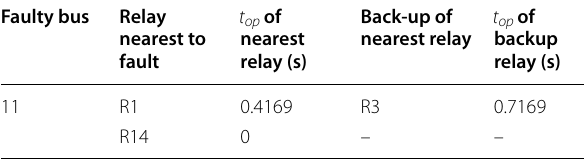
Table 4 TMS and t op of relay nearest to fault and the back-up relay (after splitting) in the IEEE 14-bus